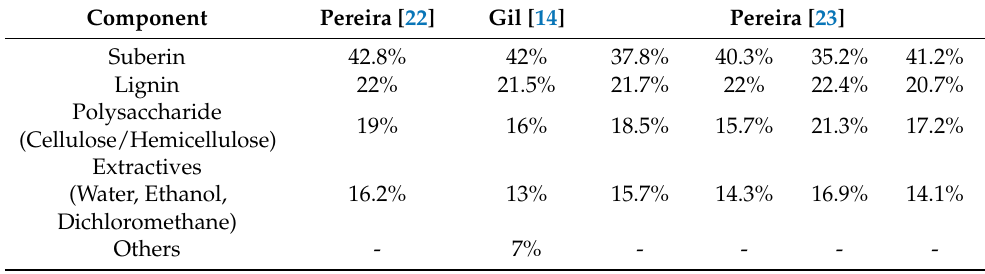
Table 2. Chemical composition of cork.